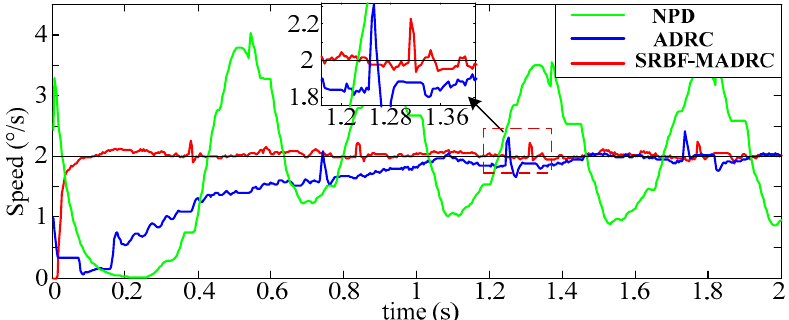
Figure 16. Experimental results of low-speed tracking.